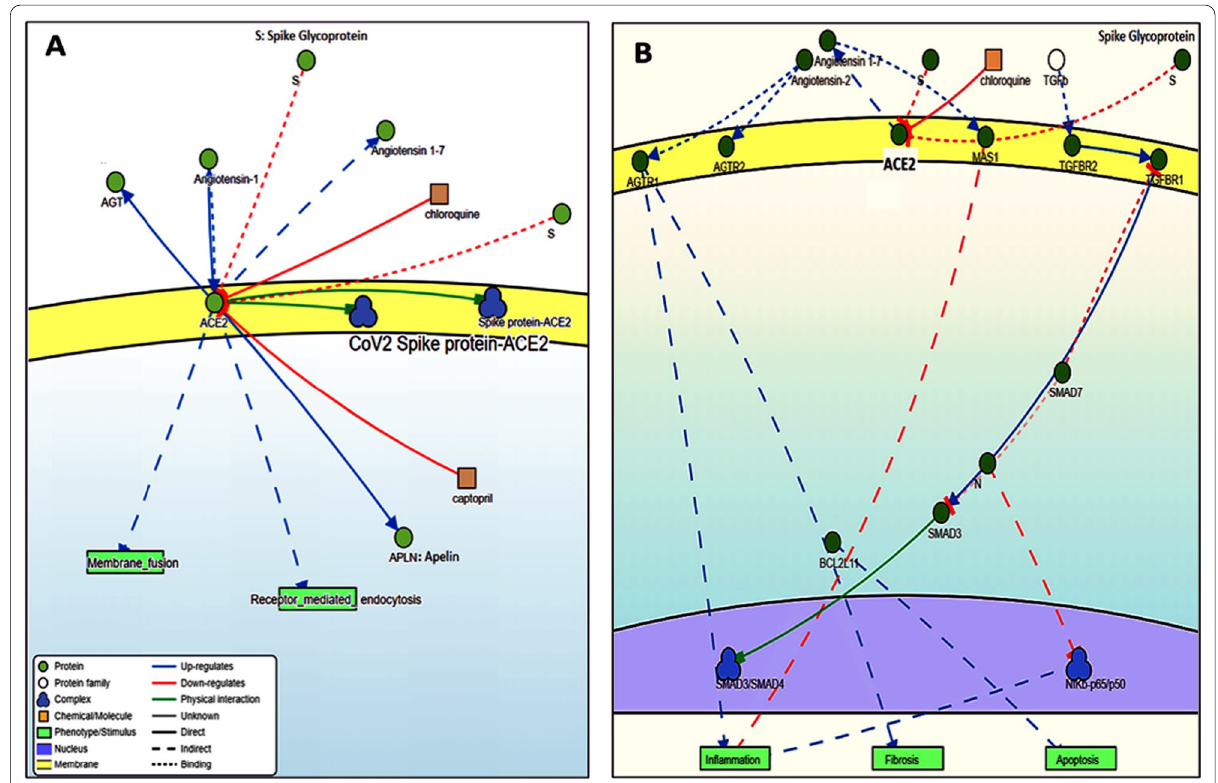
Fig. 2 ACE2 signaling network. A ACE2 interacts with several molecules, including S-protein. B The role of ACE2 in lung fibrosis. TGF-β1 is an essential mediator of fibrosis by activating downstream “SMAD” signaling, which triggers pro-fibrotic genes overexpression. Smad3 is the central canonical mediator for fibrogenesis, while Smad7 negatively regulates the fibrosis process. The RAS also controls the fibrotic process. Down-regulation of ACE2 decreases the angiotensin 1–7 level, upregulating the AT1R signaling cascade, which in turn triggers fibrosis (Data source: https:// signor. uniro ma2.